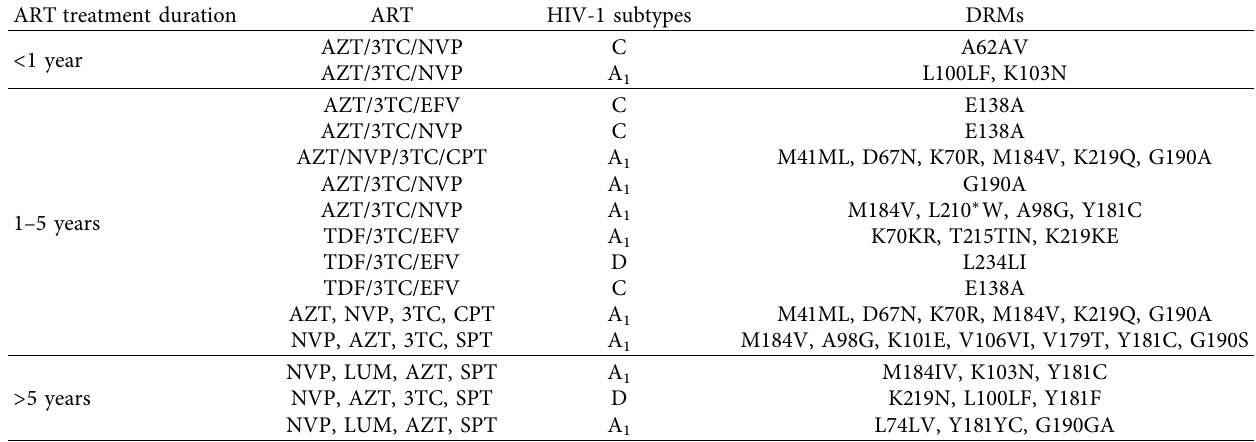
Table 6: Duration on ART and drug-resistant mutations among HIV-1